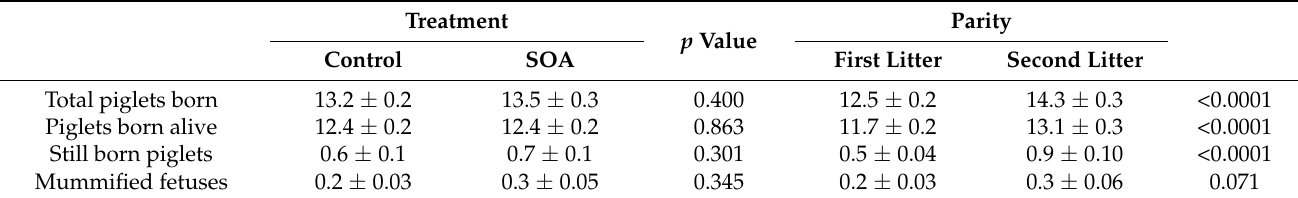
Table 2. Treatment and parity effects on piglets born within the commercial validation study (mean ± SEM).